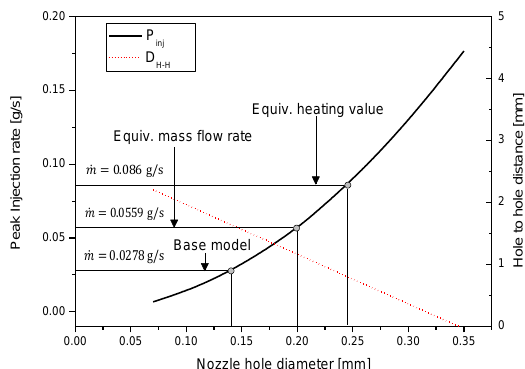
Figure 7. Peak injection rate according to nozzle hole diameter for the base injector.